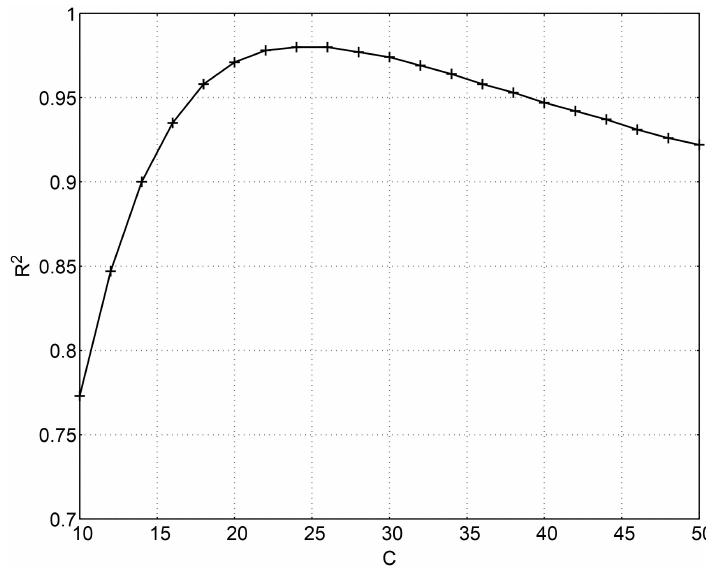
Figure 7. Coefficient of determination R 2 for different values of C